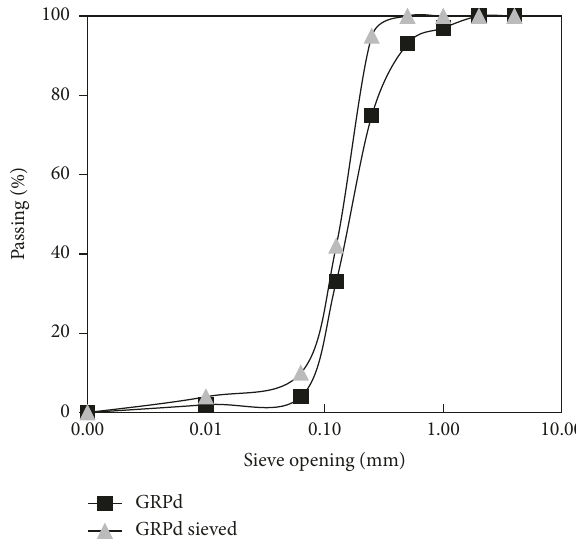
Figure 2: Particle size distribution of GRPd before and after sieving at 250 µ